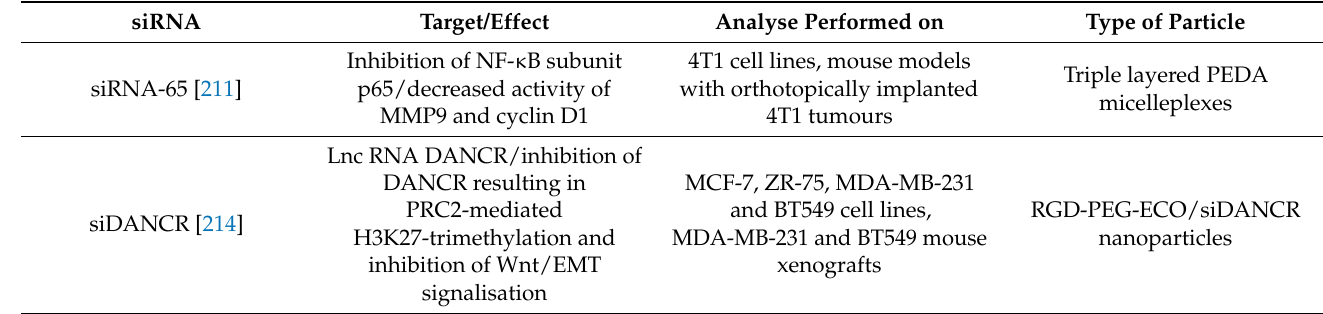
Table 5. List of RNA interferences performed in BC cell lines and animal models.